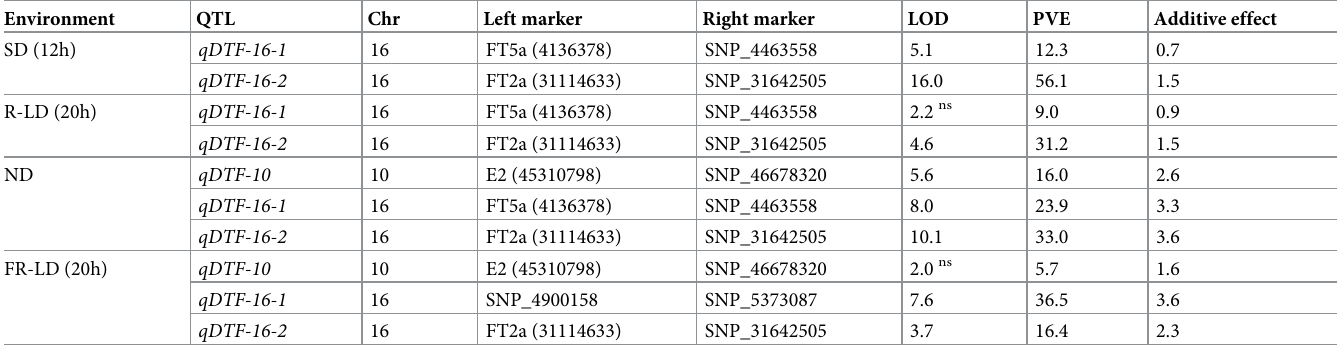
Table 1. Quantitative trait loci for flowering time in a cross between AGS292 and AK16.